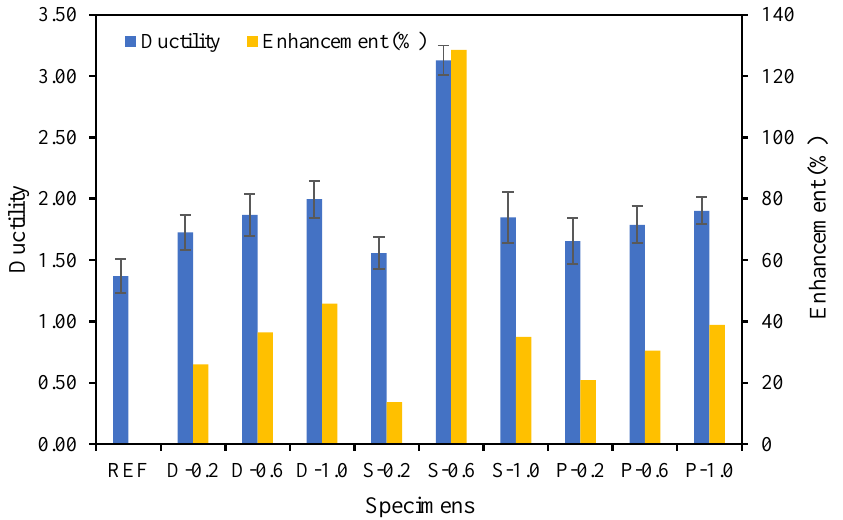
Figure 17. Ductile performance of the fibrous-reinforced concrete.